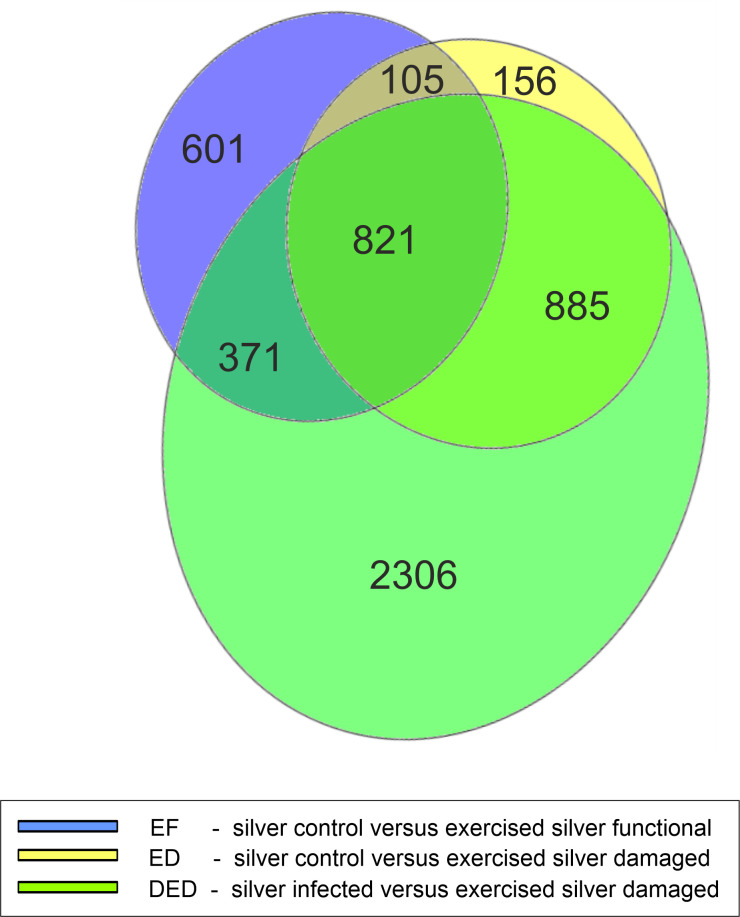
Number and overlap of differentially expressed genes.Venn diagram showing the total number of annotated genes of the comparisons (p < 0.05) between silver control (SC) with exercised eels with functional swimbladder in blue, SC with exercised eels with damaged swimbladder in yellow, and silver control eels with damaged swimbladder (SD) with exercised eels with damaged swimbladder in green, with the corresponding overlaps. Diagram was generated with eulerAPE (http://www.eulerdiagrams.org/eulerAPE/) [45].